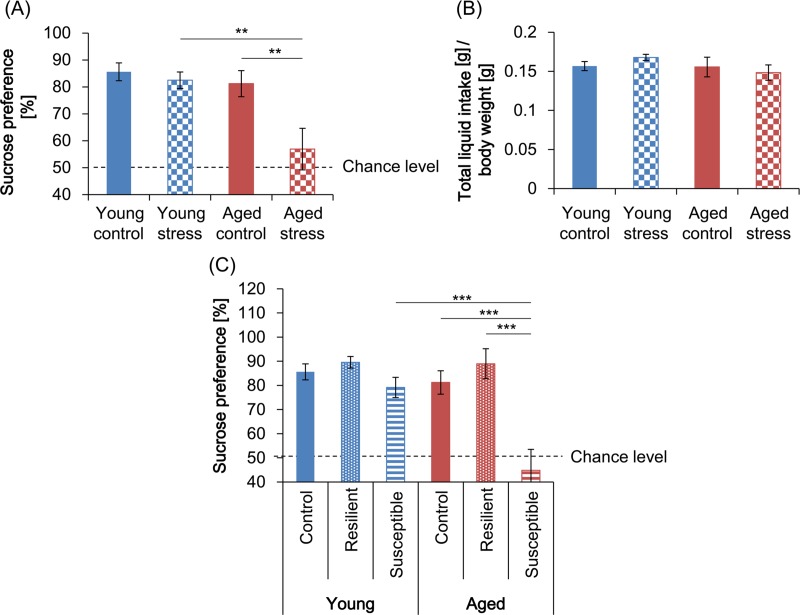
Sucrose preference in young and aged mice after mild social defeat stress (MSDS).(A) The ratio of sucrose intake to overall liquid intake and (B) overall liquid intake per body weight by young and aged mice in the stressed and control groups were measured by placing 2 bottles containing tap water and a 1% sucrose solution, respectively, in each cage and exchanging the bottle positions (left vs right) each day for 3 consecutive days, then averaging the values for each mouse. (C) The sucrose preference in control, resilient, and susceptible subgroups is shown. Data are presented as means ± standard error of the mean (SEM) (young control, n = 22; young stressed, n = 22; aged control, n = 20; aged stressed, n = 22; young resilient, n = 7; young susceptible, n = 15; aged resilient, n = 6; aged susceptible, n = 16). **: p < 0.01; ***: p < 0.001 (Bonferroni test).